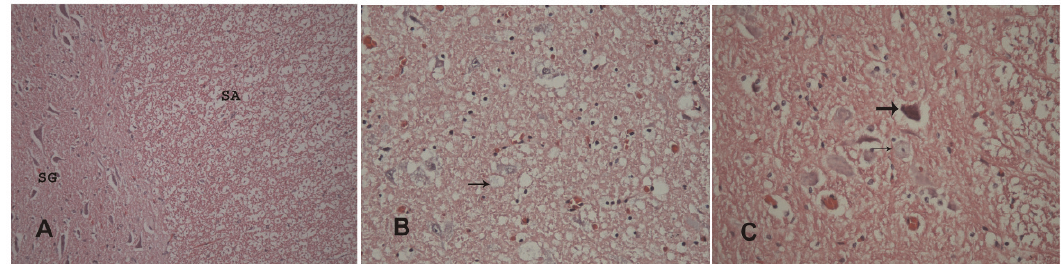
Figure 3 - A) Histopathological features of the spinal cords of rabbits with healthy cells in the substantia grisea (SG) and a mild level of vacuolization in the substantia alba (SA) (H&E, 200 6 ). B) Representative micrograph showing a moderate level of vacuolization (arrow) in the cells of the substantia grisea (H&E, 400 6 ). C) Representative micrograph showing vacuolization, neurons containing pyknotic nuclei (thick arrow) and sparse Nissl-stained substances (thin arrow) in the cytoplasm of the large neurons in the substantia grisea (H&E, 400 6